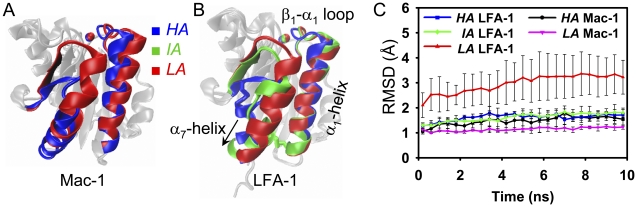
Conformational difference of LFA-1/Mac-1 I domains in different affinity states.Crystal structures of Mac-1 (A) and LFA-1 (B) were superposed, respectively, in three affinity states of HA (blue), IA (green), and LA (red). Metal ion in MIDAS (vdW presentation), β1-α1 loop, and α1- and α7-helices (newcartoon presentation) are highlighted, and other parts are presented in transparent silver newcartoon for clarity. The arrow directs the movement of α7-helix in activated allostery. Disulfide bonds introduced into the β6-α7 loop of HA LFA-1 and between α1 and α7-helix C-terminals of IA LFA-1 I domains are shown in licorice. All backbone atoms RMSD (global RMSD in brief) evolutions of five equilibrated I domains relative to their respective crystallized reference conformation are presented in (C), and error bars are the standard deviation (SD) of ten runs of LA LFA-1 and three runs of other four systems.